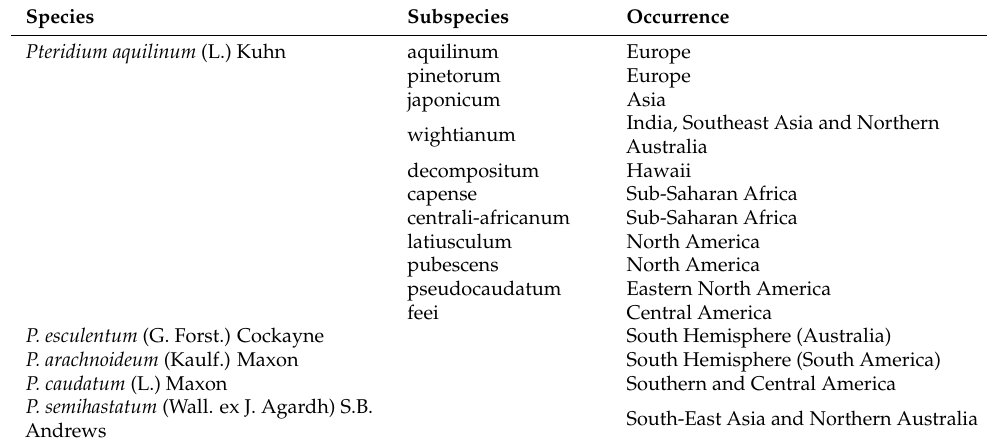
Table 2. The most important Pteridium species and subspecies of the world (after [21]). Species